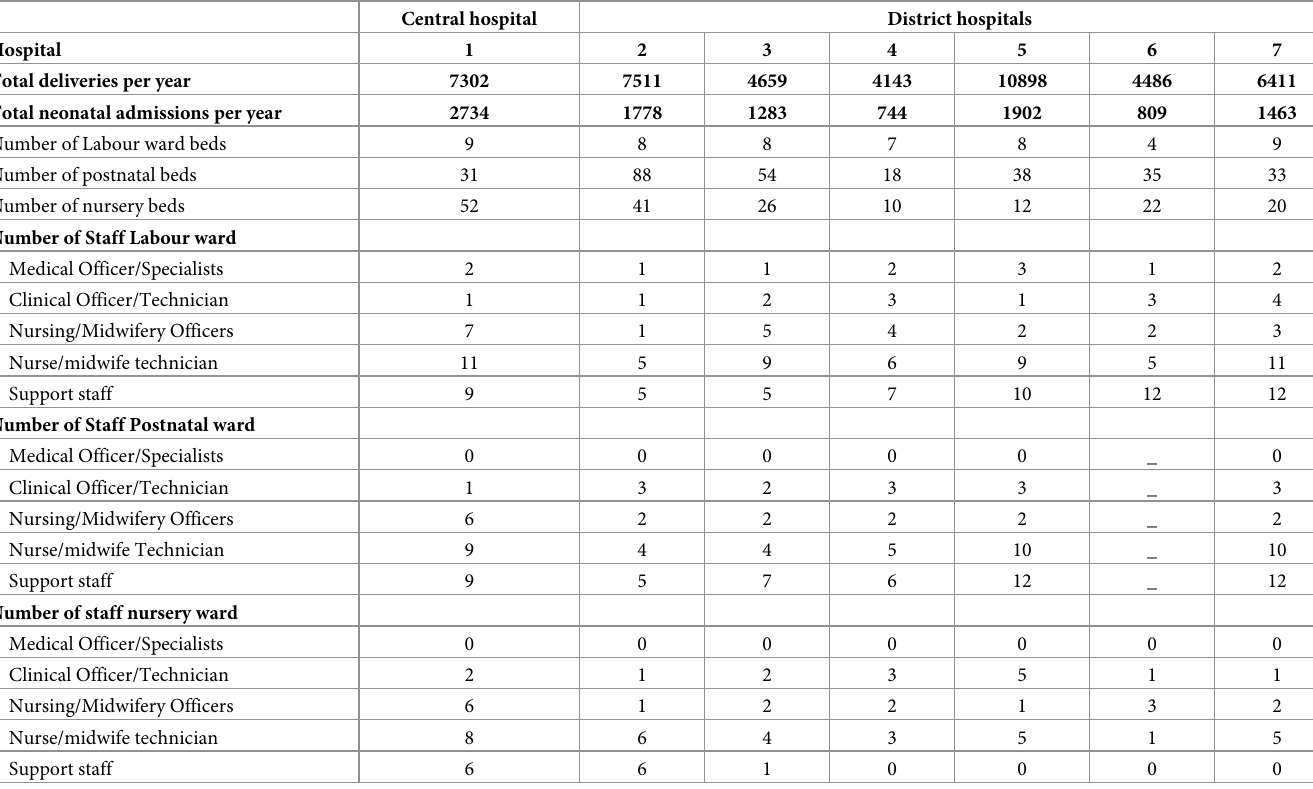
Table 1. Bed capacity and staffing levels 1,2,3